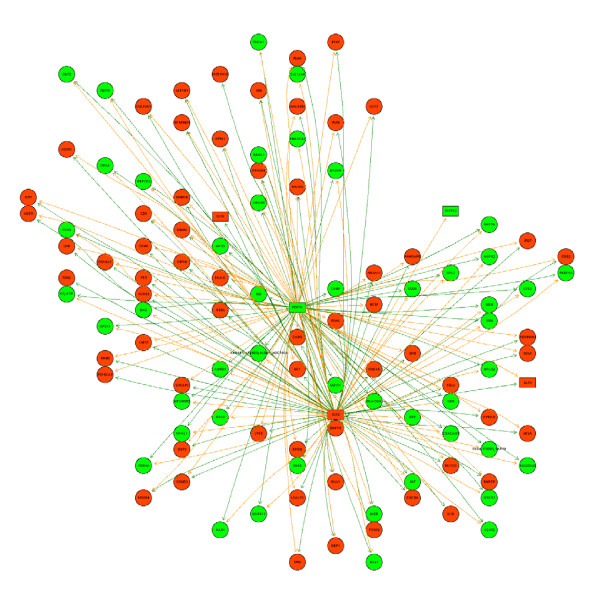
Results from functional profiling of data using Onto-Express. (A) The figure shows the significant (red) biological processes represented in a set of genes differentially expressed between two clinical groups. (B) The figure shows the significant (red) molecular function represented in a set of genes differentially expressed between two clinical groups.